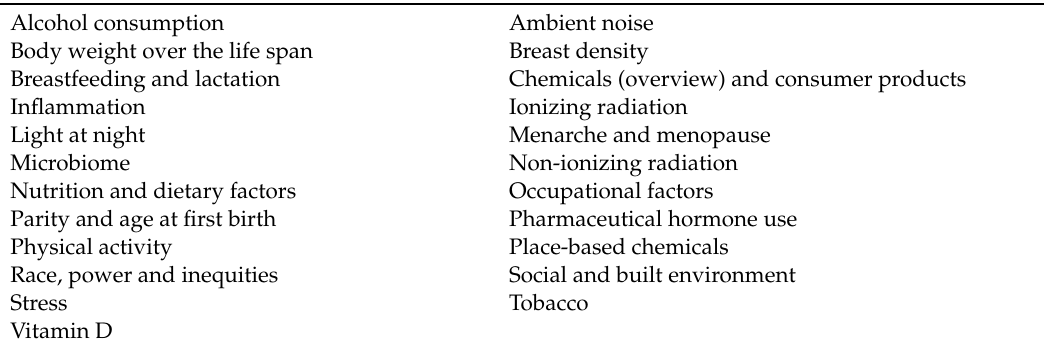
Table 1. Inventory of presumptive breast cancer risk and protective factors examined by Breast Cancer Prevention Partners